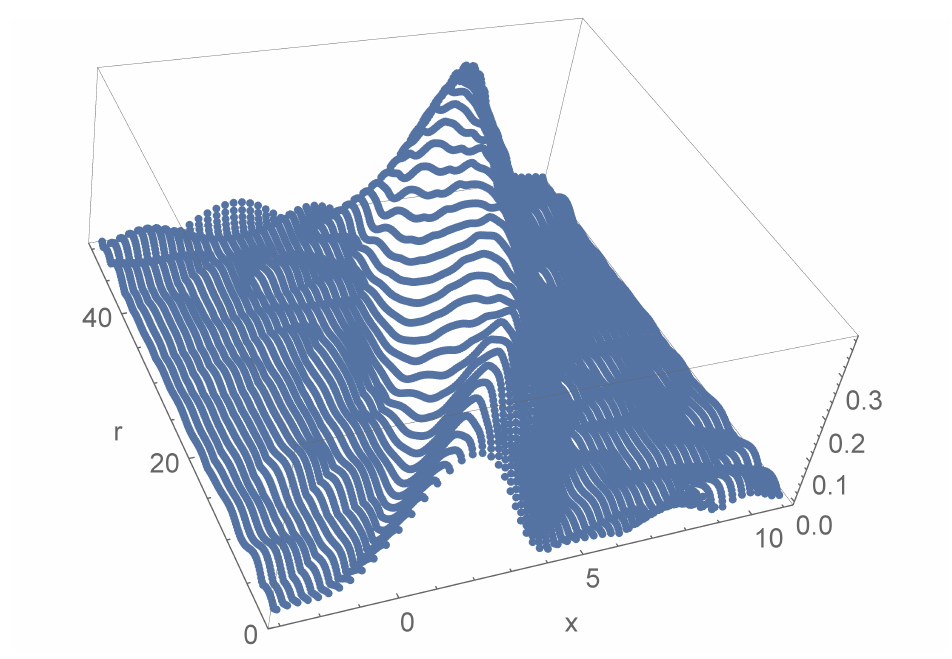
Figure 1. A result for the synthetic